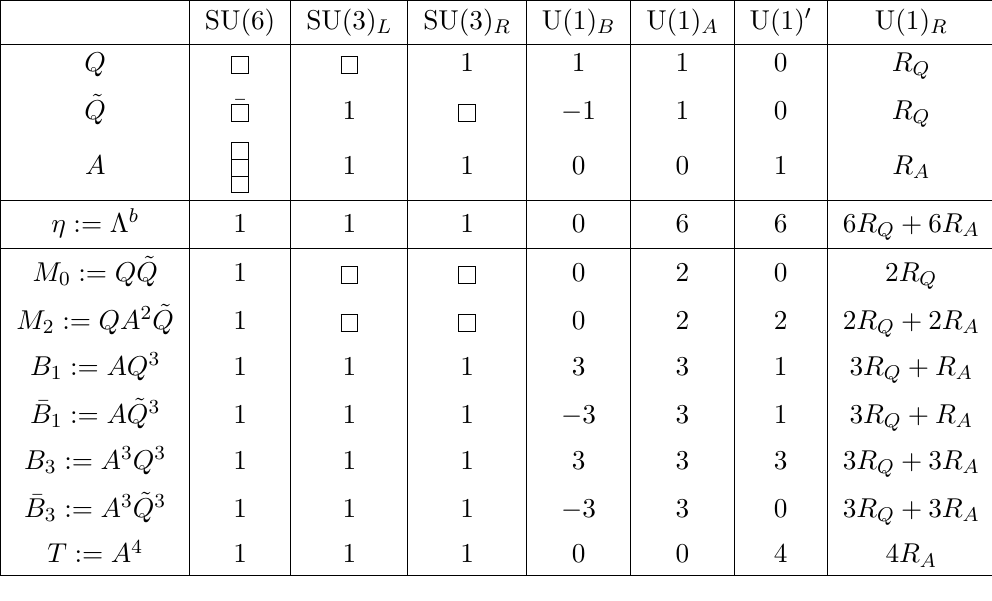
Table 2 . Quantum numbers of 4d N = 1 SU(6) with and 3 ( + ).